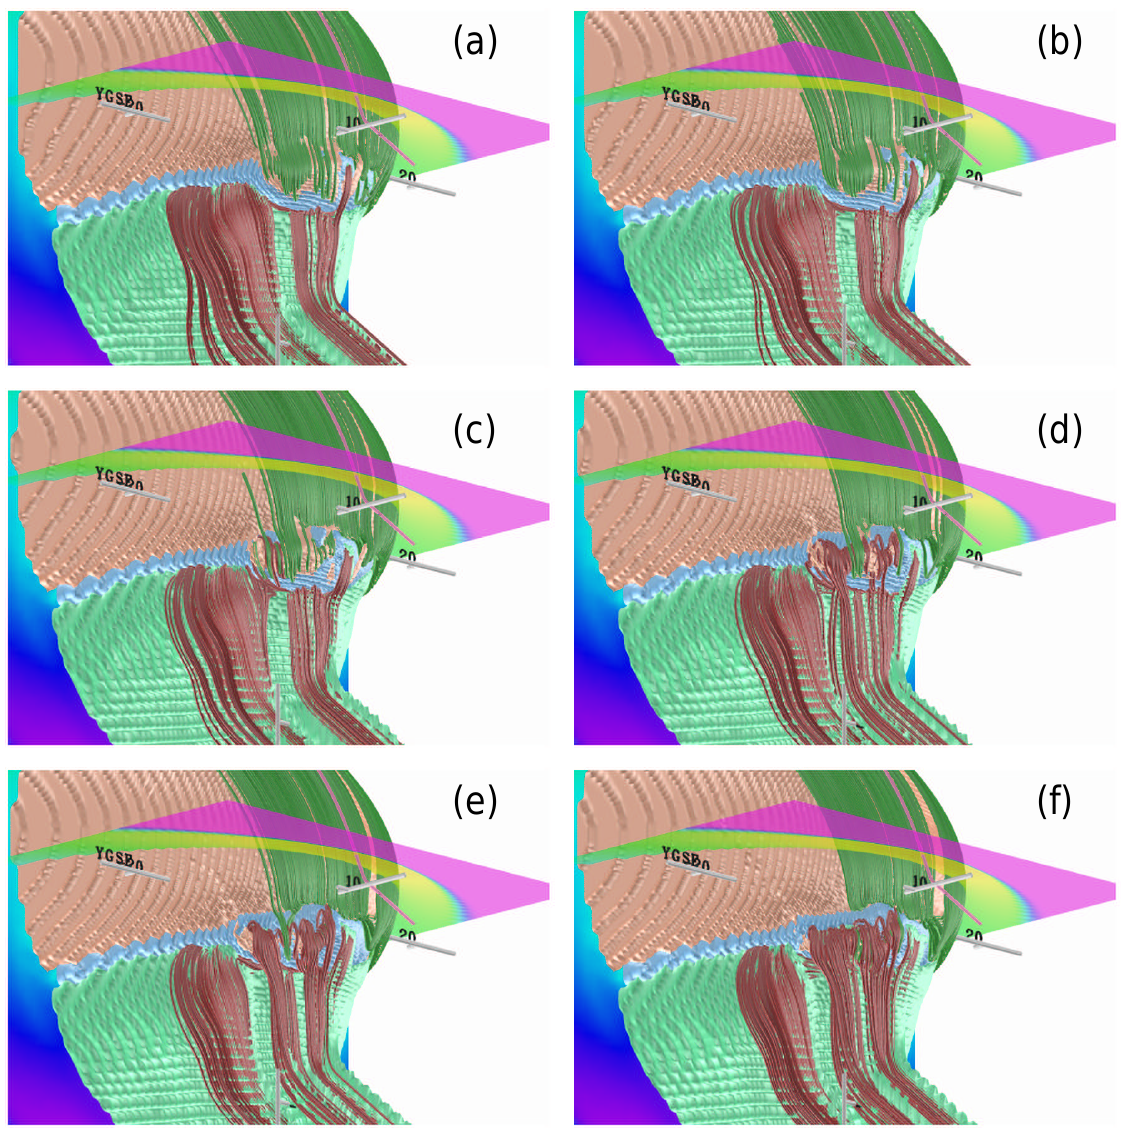
Fig. 4. Three-dimensional perspective view of FTE generation. The panels are snapshots taken every 12s. The view is from the south, dawn, and sunward side of the magnetosphere, i.e., the sun is to the right. The plane at z=3 R E is color coded with the plasma pressure. The 3 surfaces are magnetic separators, the green field lines are anchored in the Northern Hemisphere, and the red field lines are anchored in the Southern Hemisphere. The blue bands of the closed field line separator surface that are visible essentially mark the location of the X-lines present at the dayside magnetopause. See text for more